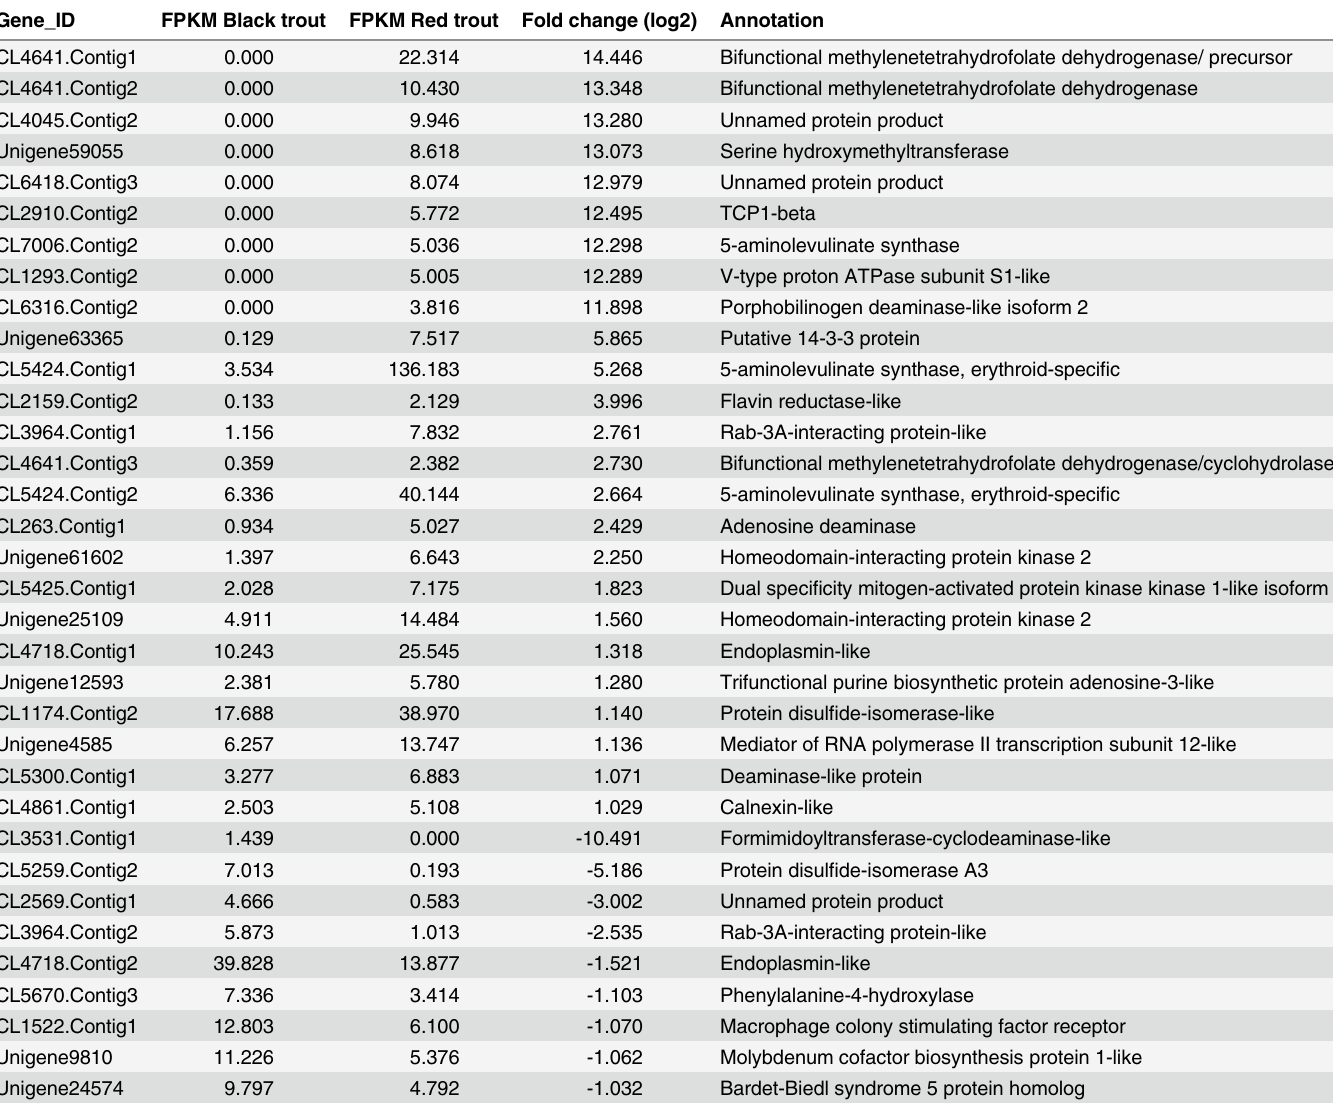
Table 3. Expression and annotation of candidate genes involved in skin color and pigmentation between black and red common coral trout. FPKM Black trout FPKM Red trout Fold change (log2)